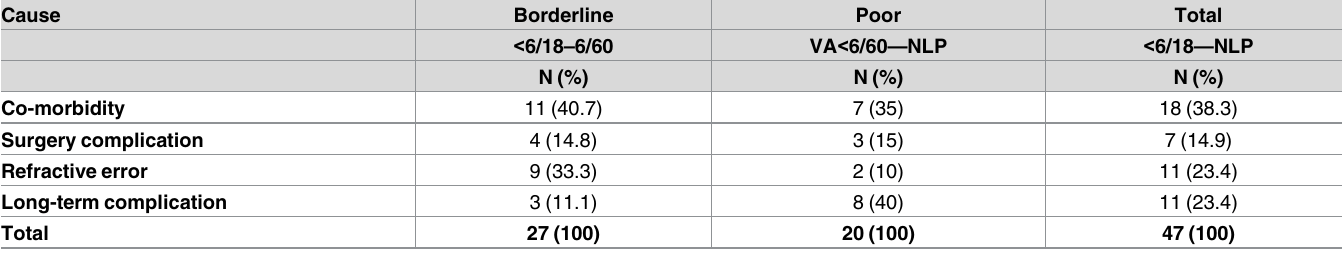
Table 5. Causes of poor and borderline visual outcome in pseudophakic eyes: Wurno health zone 2016.